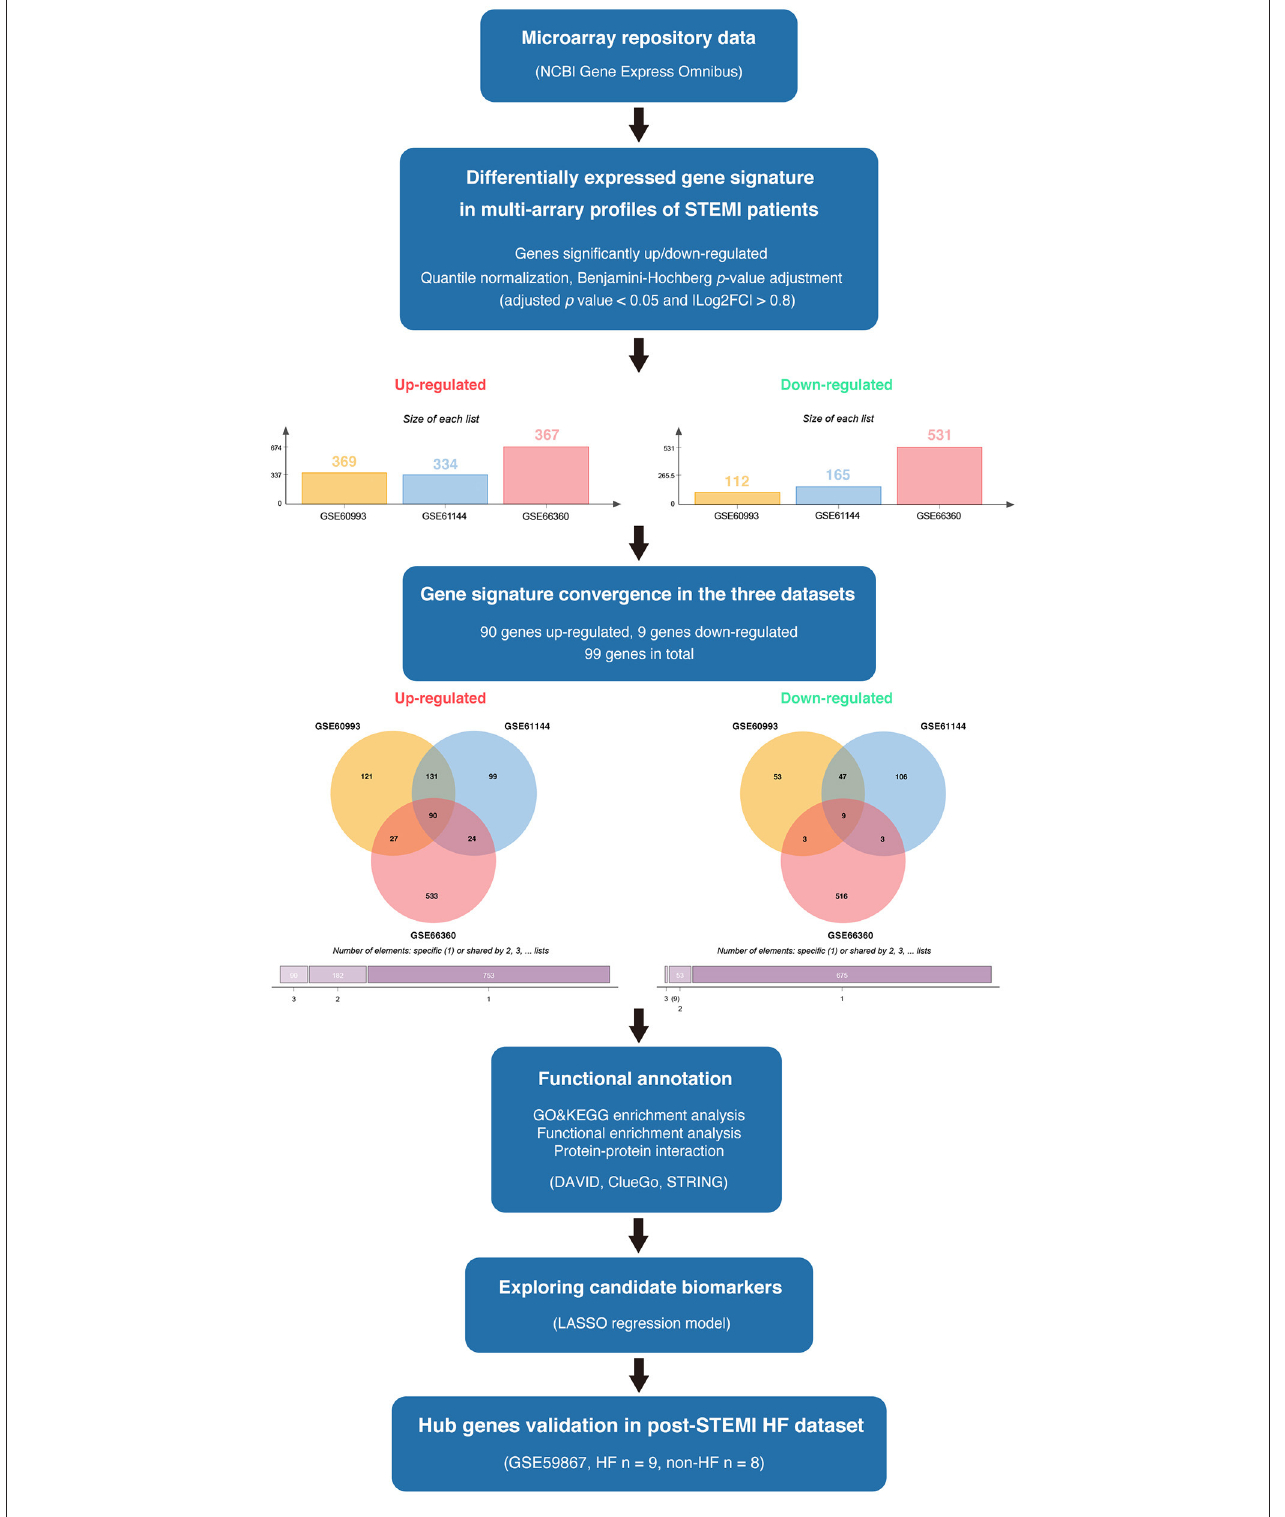
FIGURE 1 | The overview of the analysis procedure. We downloaded GSE60993, GSE61144, and GSE66360 from the NCBI-GEO database and identified 90 upregulated DEGs and nine downregulated DEGs convergence in the three datasets (|log 2 FC| ≥ 0.8 and adjusted p < 0.05). Gene ontology and pathway enrichment were performed via ClueGO (version 2.5.7), CluePedia (version 1.5.7), and the DAVID database. A protein interaction network was constructed via STRING. Enriched hub genes were analyzed by Cytoscape software. The logistic LASSO regression was performed to build a machine learning model. GSE59867 dataset was utilized to validate the hub genes in patients with post-STEMI